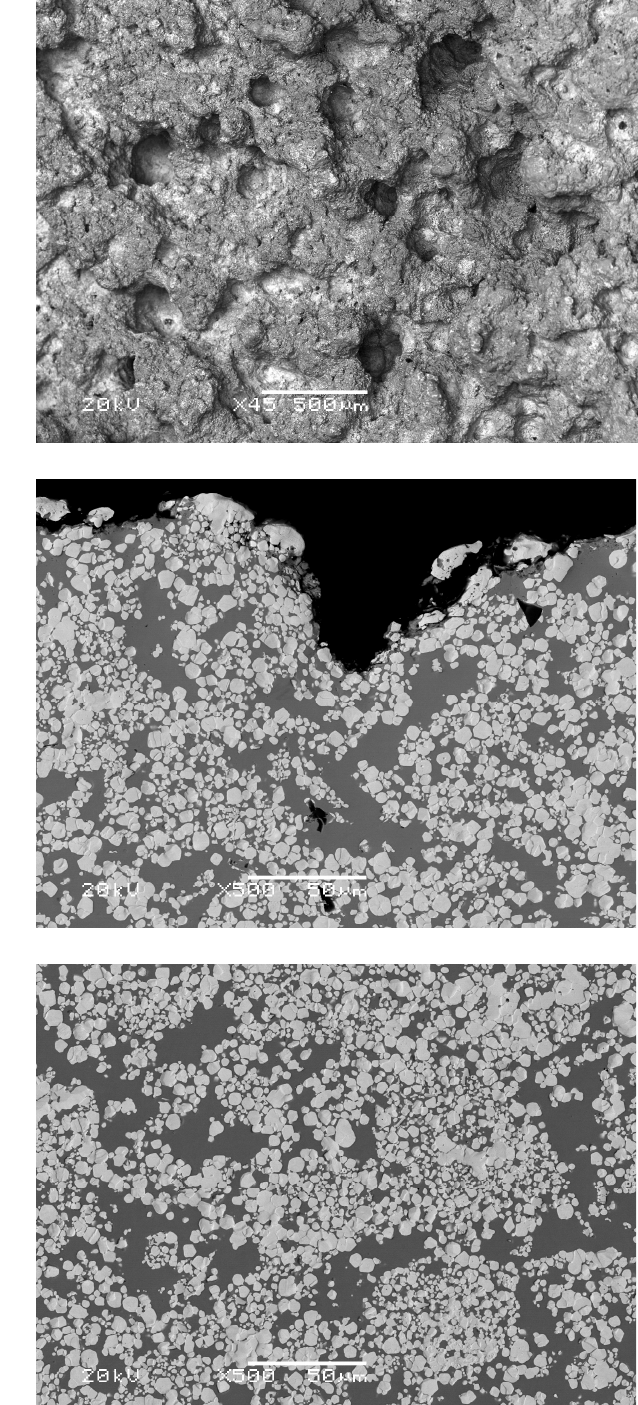
FIG. 6. Backscattered electron micrograph for Mallory 1000. The top picture is a surface picture of an arc region. The middle picture is a cross section of an arced region. The bottom picture is a cross section of the bulk